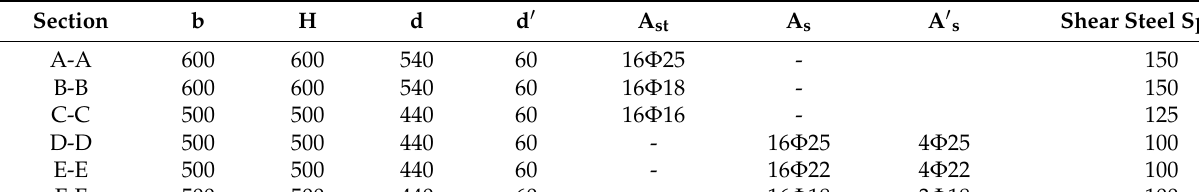
Table 4. The details of the designed frame (mm) [34].